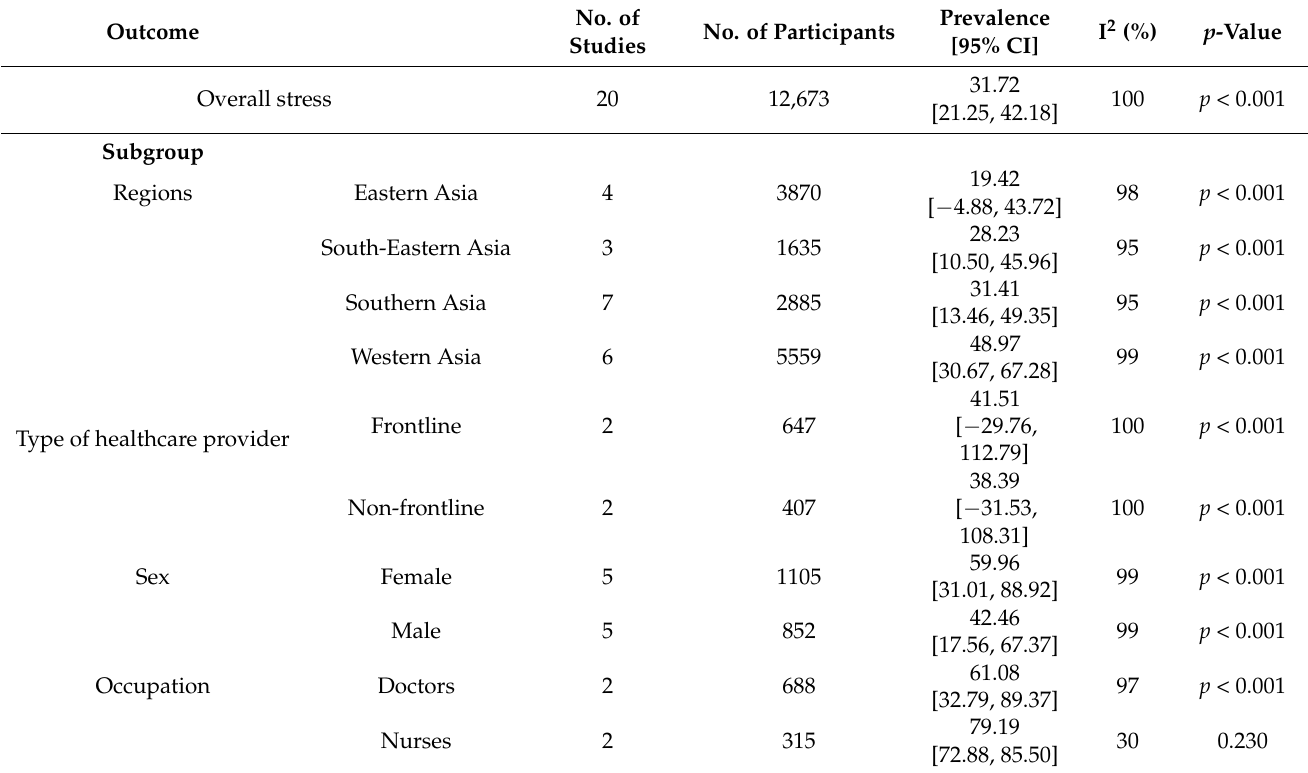
Table 3. Pooled prevalence of stress and subgroup analysis.